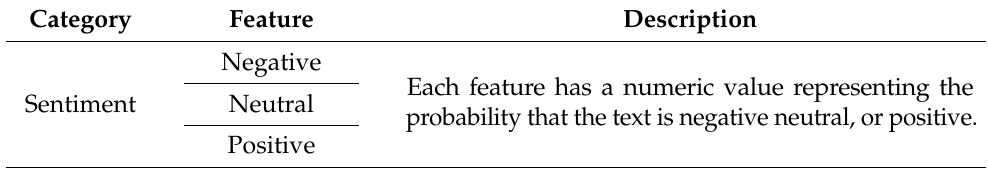
Table 5. Features extracted from